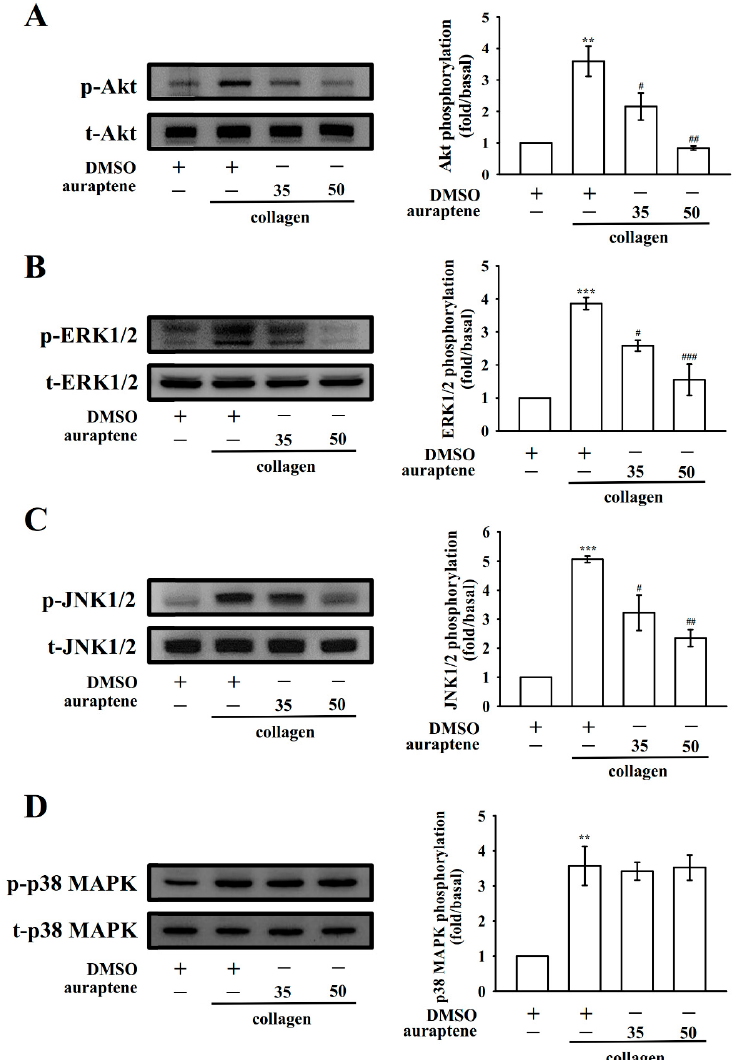
Figure 5. E ff ects of auraptene on Akt, ERK1 / 2, JNK1 / 2, and p38 MAPK phosphorylation in collagen-activated platelets. Washed platelets were preincubated with 0.1% DMSO or auraptene (35 and 50 µ M) and then treated with collagen (1 µ g / mL) for ( A ) Akt, ( B ) ERK1 / 2, ( C ) JNK1 / 2, and ( D ) p38 MAPK phosphorylation. Data are given as mean ± SEM ( n = 4). ** p < 0.01 and *** p < 0.001, compared with the resting platelets; # p < 0.05, ## p < 0.01, and ### p < 0.001, compared with the DMSO-treated group.